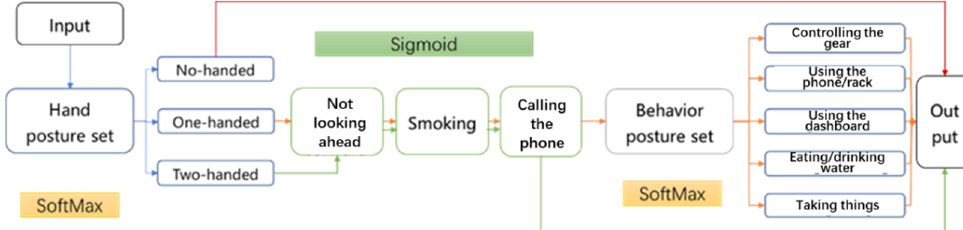
Figure 9. Structure of cascaded CNN models.